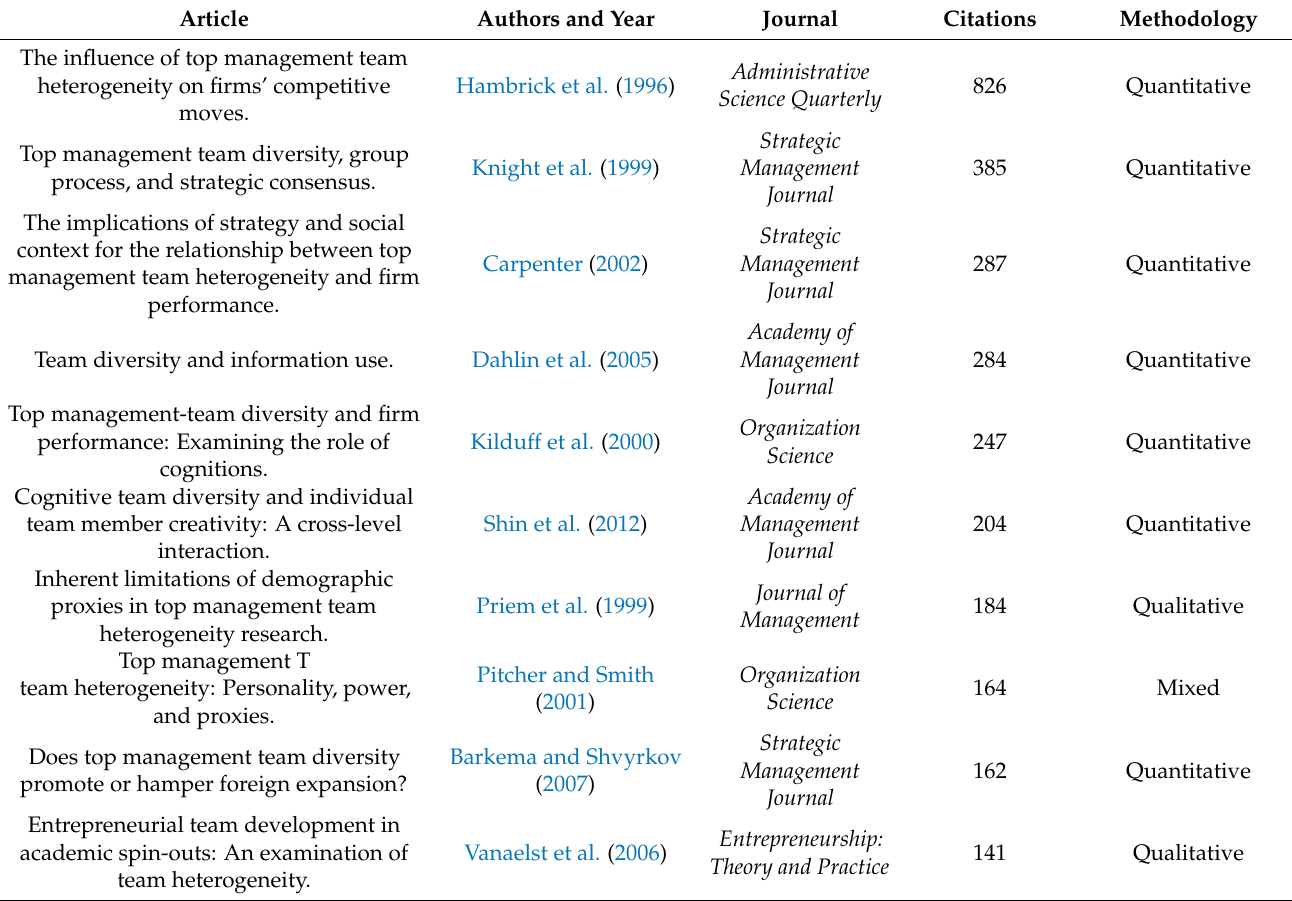
Table 2. Top ten most-cited articles.